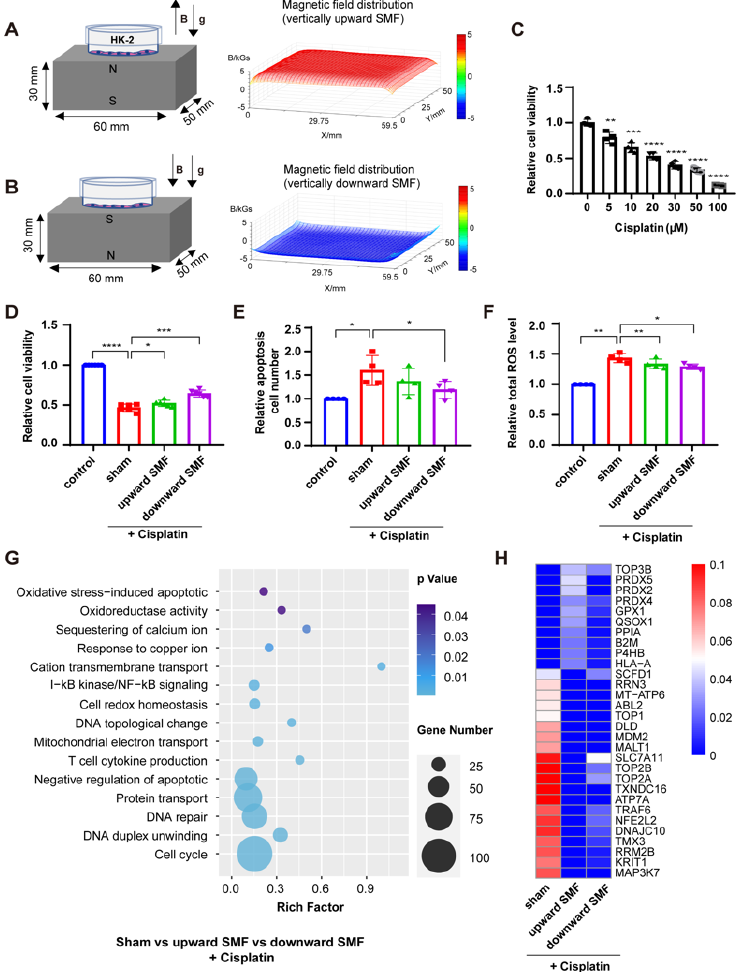
Figure 1. SMFs protect HK-2 cells from cisplatin-induced cytotoxicity. ( A , B ) Experimental setup and magnetic field distribution for cells exposed to vertically upward SMF ( A ), or vertically downward SMF ( B ). The SMFs at the cells are ~0.4 T. ( C ) HK-2 cell viability after 24 h cisplatin treatment at different concentrations. Relative cell viability ( D ), apoptosis ( E ), and ROS levels ( F ) of HK-2 cells with or without 20 μM cisplatin and /or SMFs for 24 h. All experiments were repeated more than three times. ( G ) GO term of the differentially expressed genes according to RNA-seq in cisplatin- treated HK-2 cells with or without SMFs. Differential fold change ≥ 2 (i.e., absolute value of log 2 FC ≥ 1) was used as the threshold of change and p -value < 0.05 as the criterion for screening differential genes (|log 2 FC| ≥ 1 and p < 0.05) in the set comparison group to obtain differentially expressed genes. ( H ) The gene expression heatmap shows the 30 differentially expressed genes in cisplatin- treated cells with or without SMFs. The heatmap was produced using the average transcript expres- sion of three samples in each group. Data are represented as means ± SD. * p < 0.05, ** p < 0.01, *** p < 0.001, **** p < 0.0001.